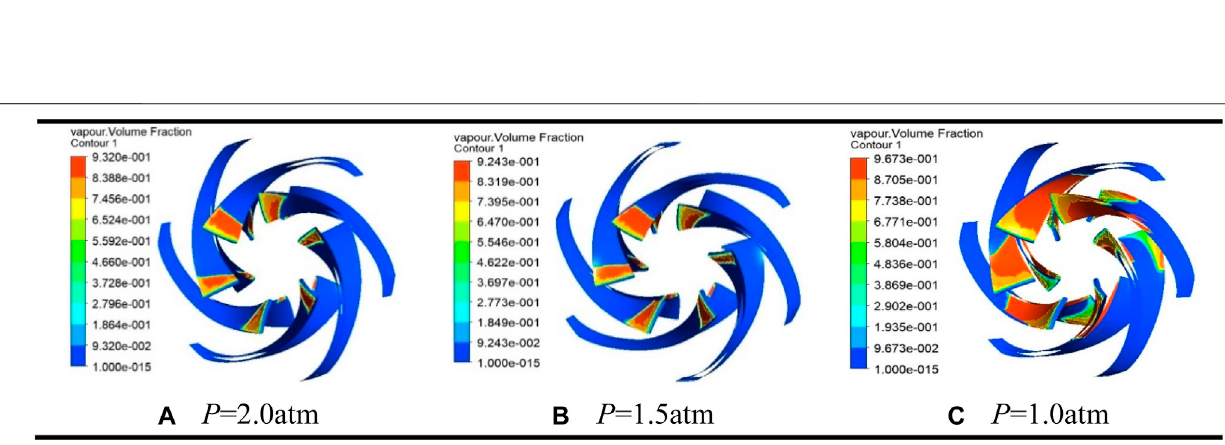
Frontiers in Energy Research |